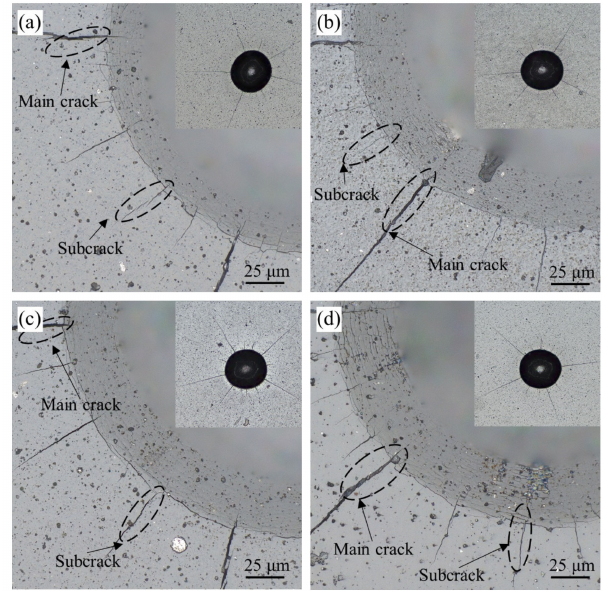
Figure 7. Indentation profiles of the coatings at different bias voltages: ( a ) − 60 V; ( b ) − 80 V; ( c ) − 100 V; ( d ) − 120 V.